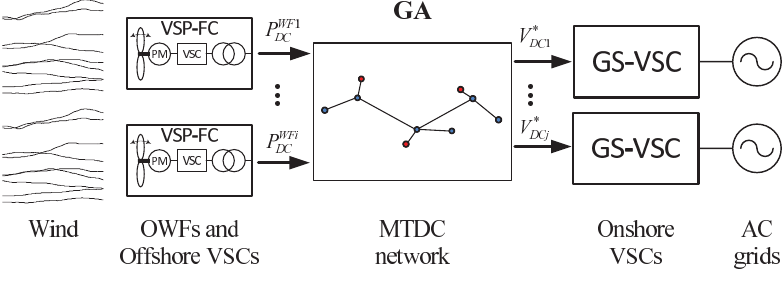
Figure 10. How information flows in the distributed voltage control method.